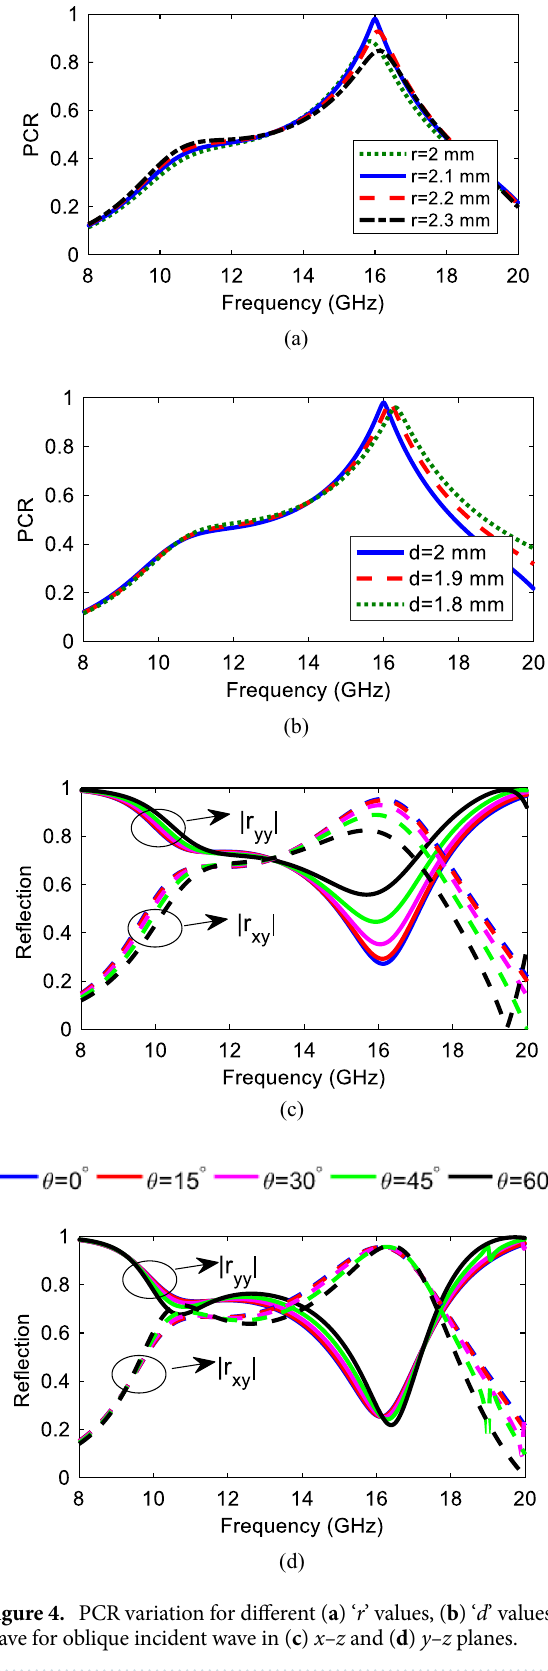
Figure 4. PCR variation for different ( a ) ‘ r ’ values, ( b ) ‘ d ’ values, Magnitude of the Co- and Cross-polarized wave for oblique incident wave in ( c ) x–z and ( d ) y–z